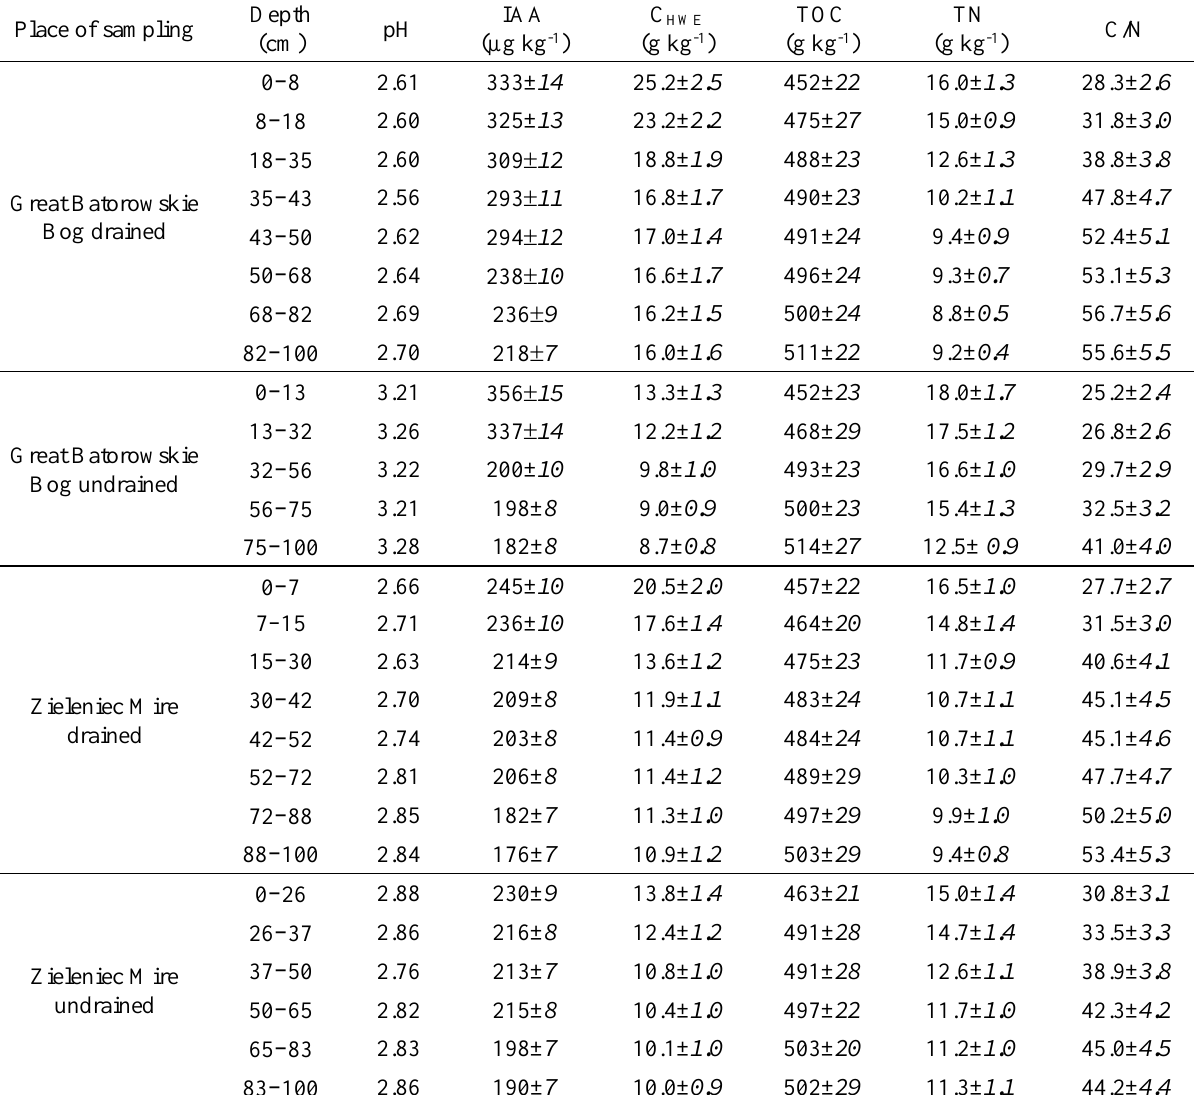
Table 3. Mean contents of chemical compounds and physical factors in the investigated soils (Polish site). IAA = indole-3-acetic acid, C HWE = hot water extractable organic carbon, TOC = total organic carbon, TN = total nitrogen, C/N = C/N quotient, x ± Δx = confidence interval of average at confidence level α = 0.05 for (n - 1) degrees of